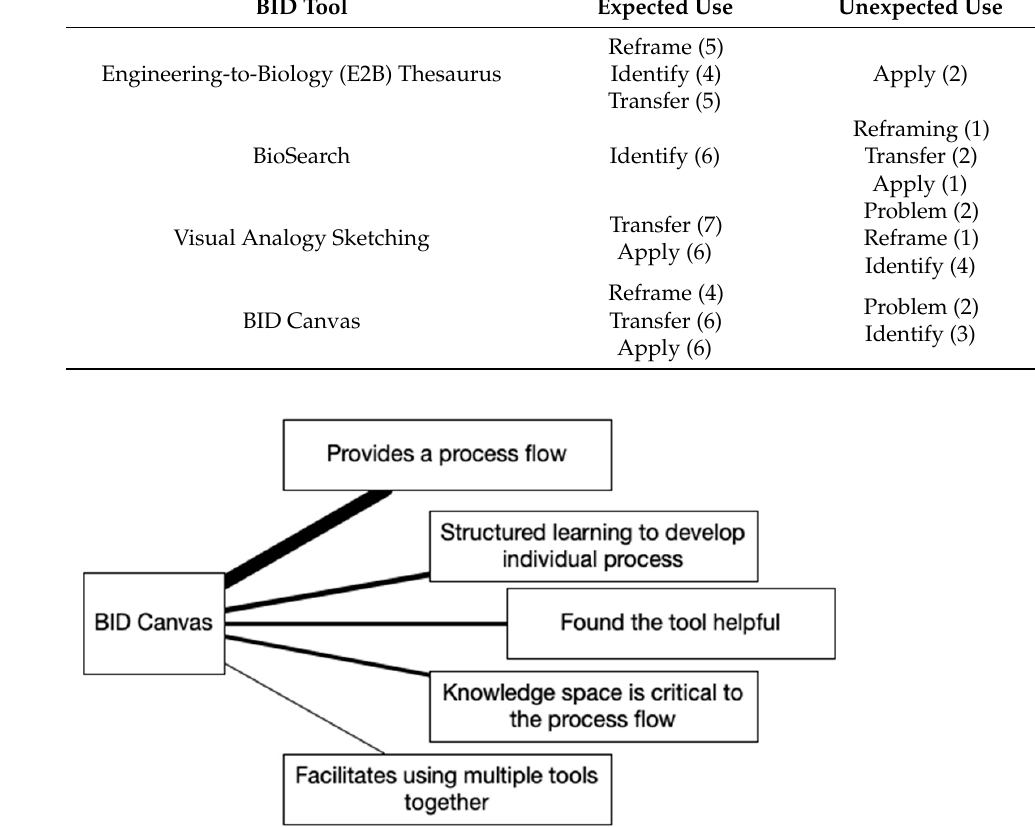
Figure 3. BID Canvas discussion themes.